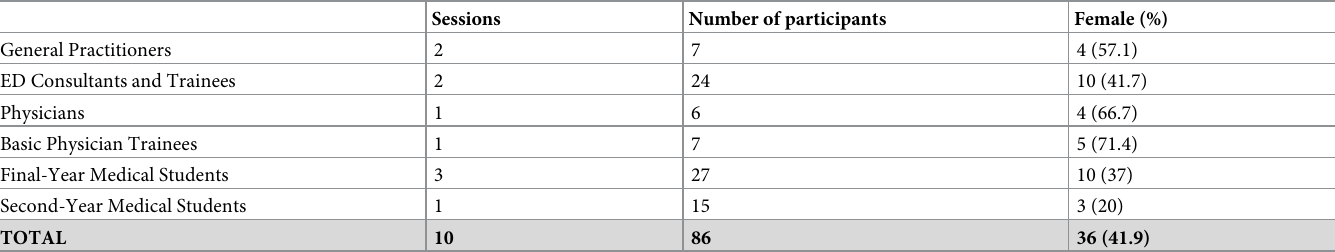
Table 1. Focus group participant numbers and demographics.